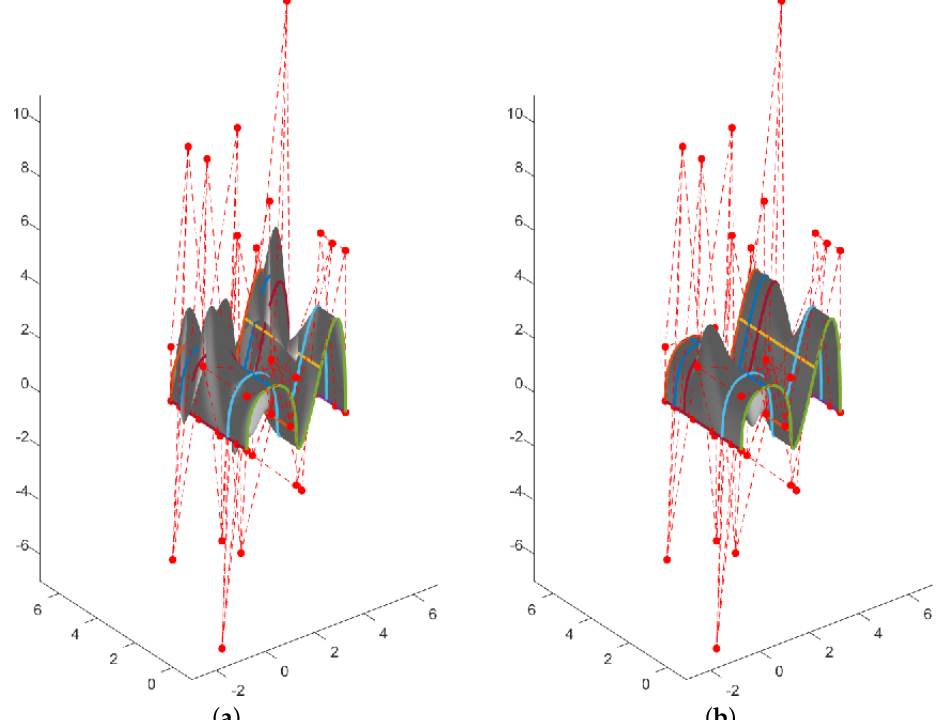
0,0,0,1,2,3,4,4,4 , { }